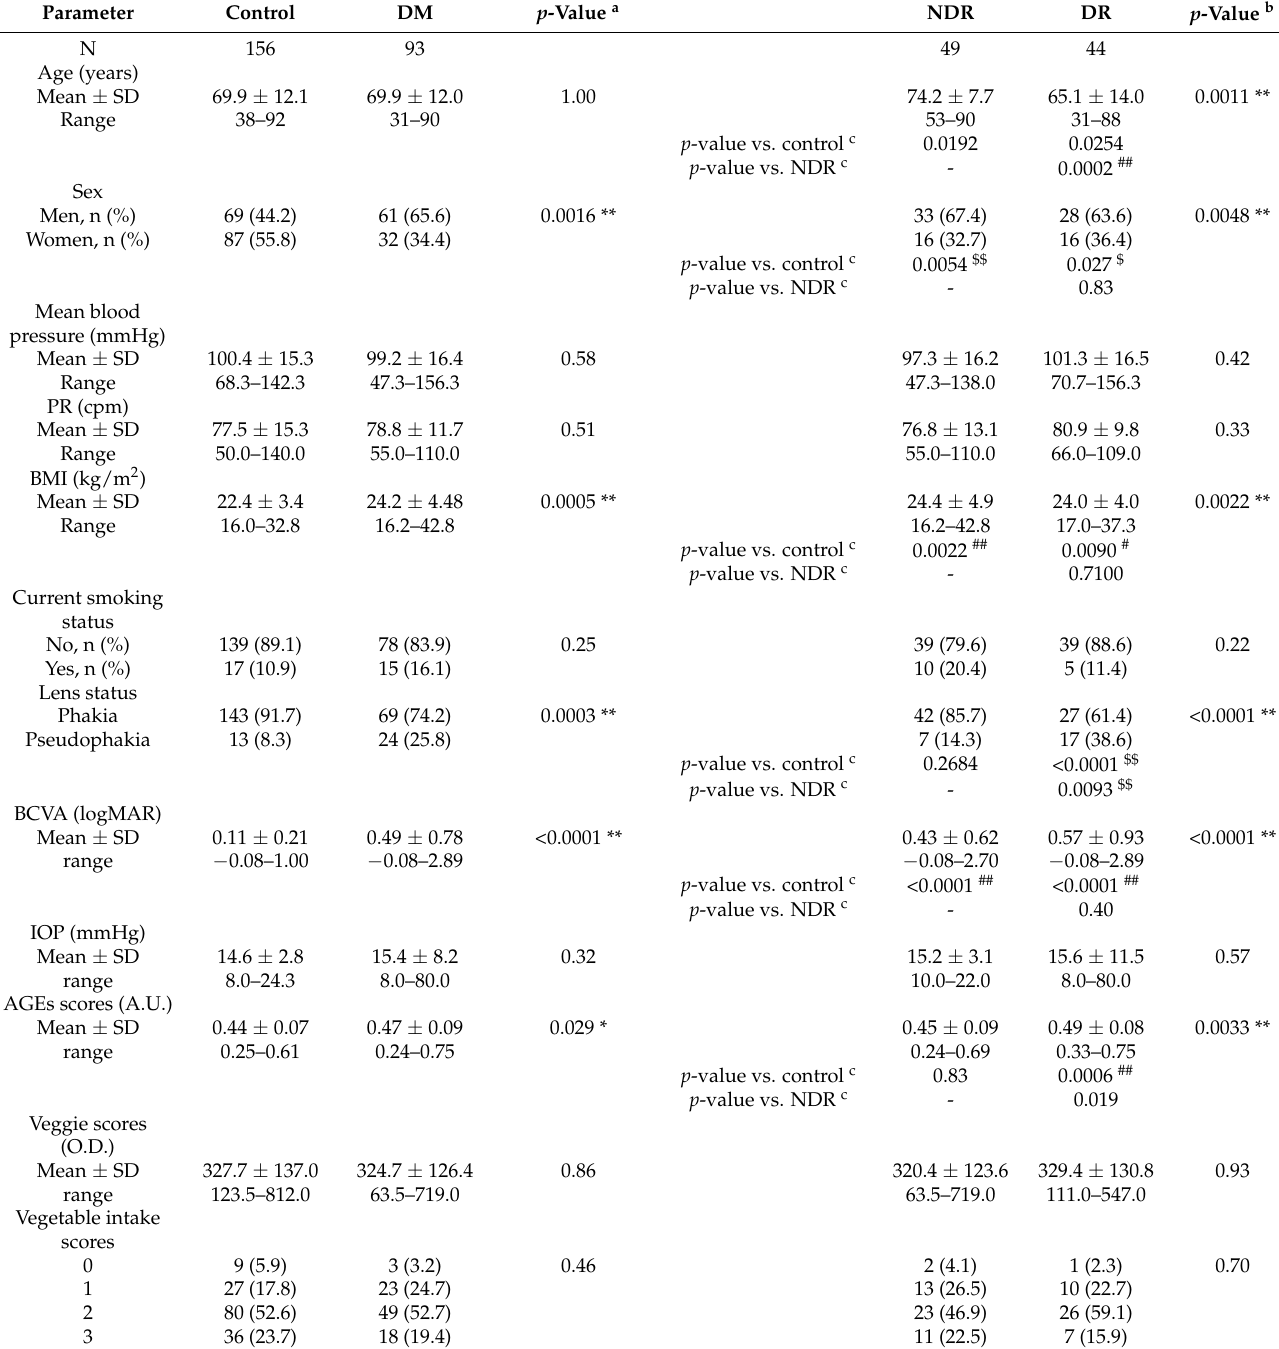
Table 1. Demographic subject